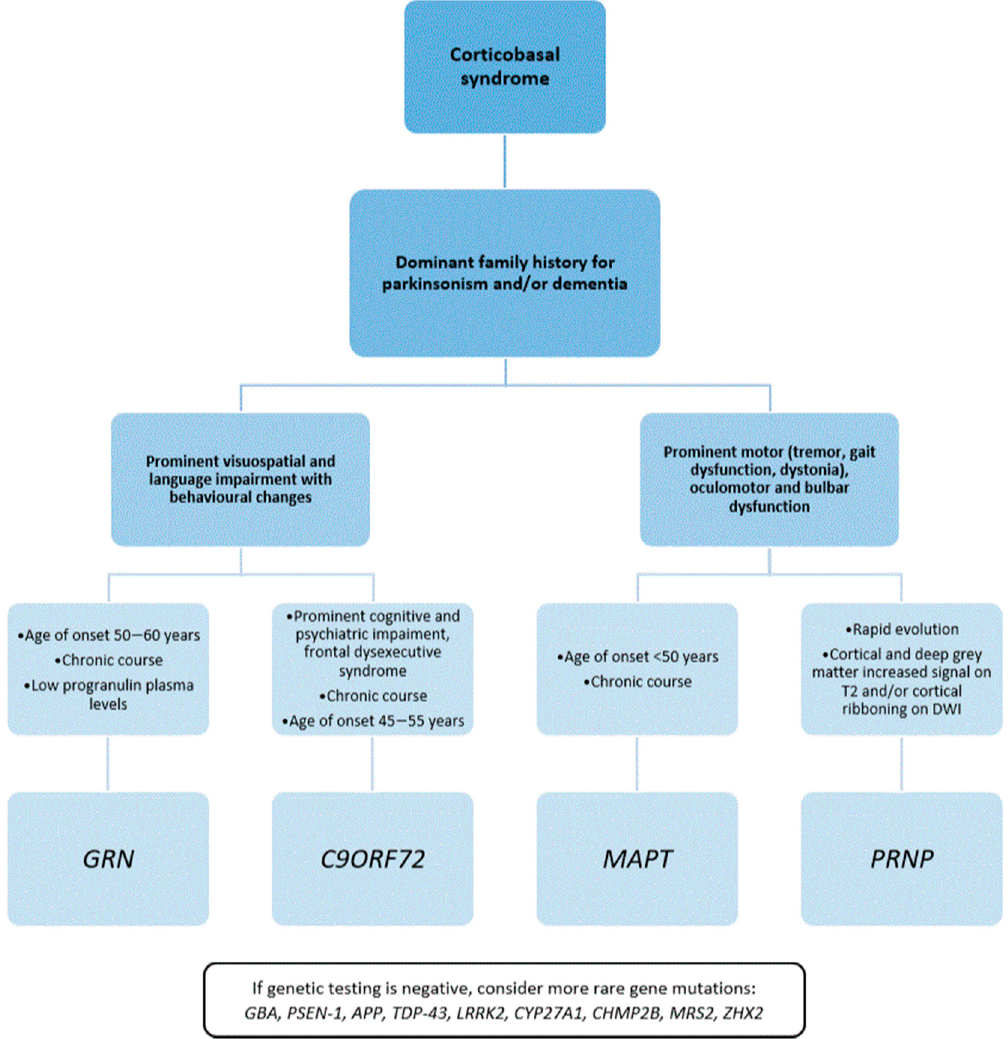
Figure 2. Diagnostic algorithm for screening genetic causes of